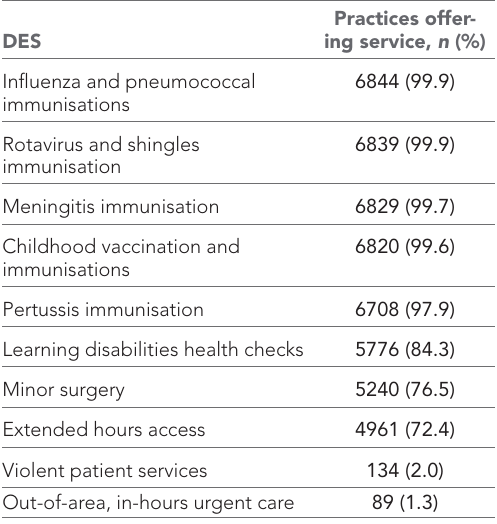
Table 1 Summary of available DES and